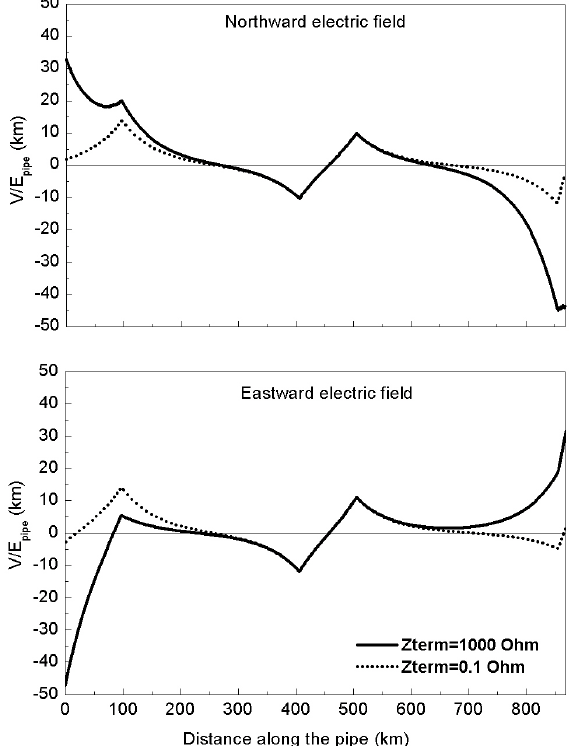
Fig. 8. Ratio of pipe-to-soil potential to the pipeline electric field based on DSTL model for Norman Wells – Zama pipeline. Solid line represents high terminating impedance (1000Ohm), dotted line – low terminated impedance (0.1Ohm).